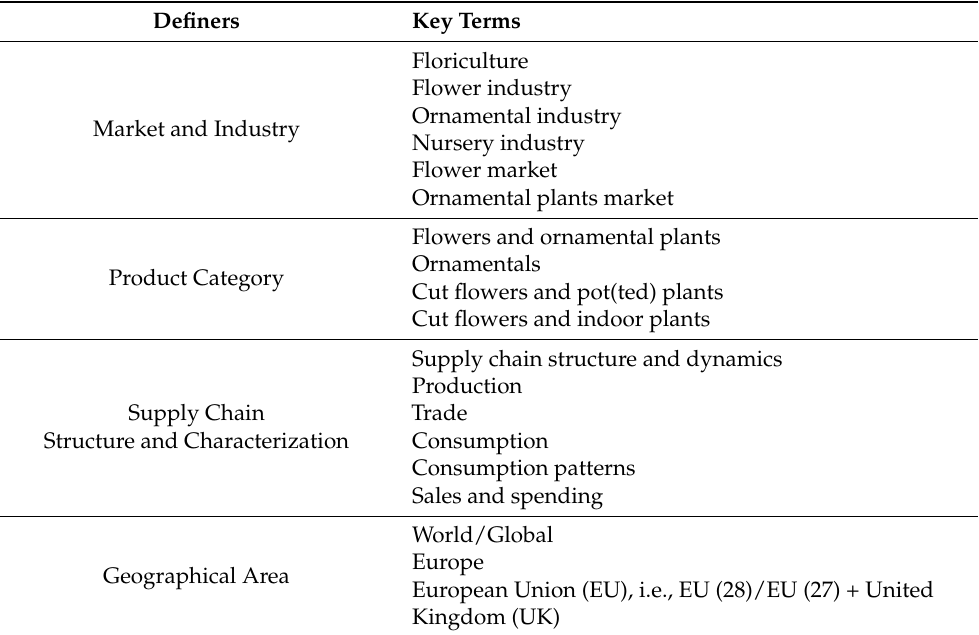
Table 1. Key terms for research topic definition and online